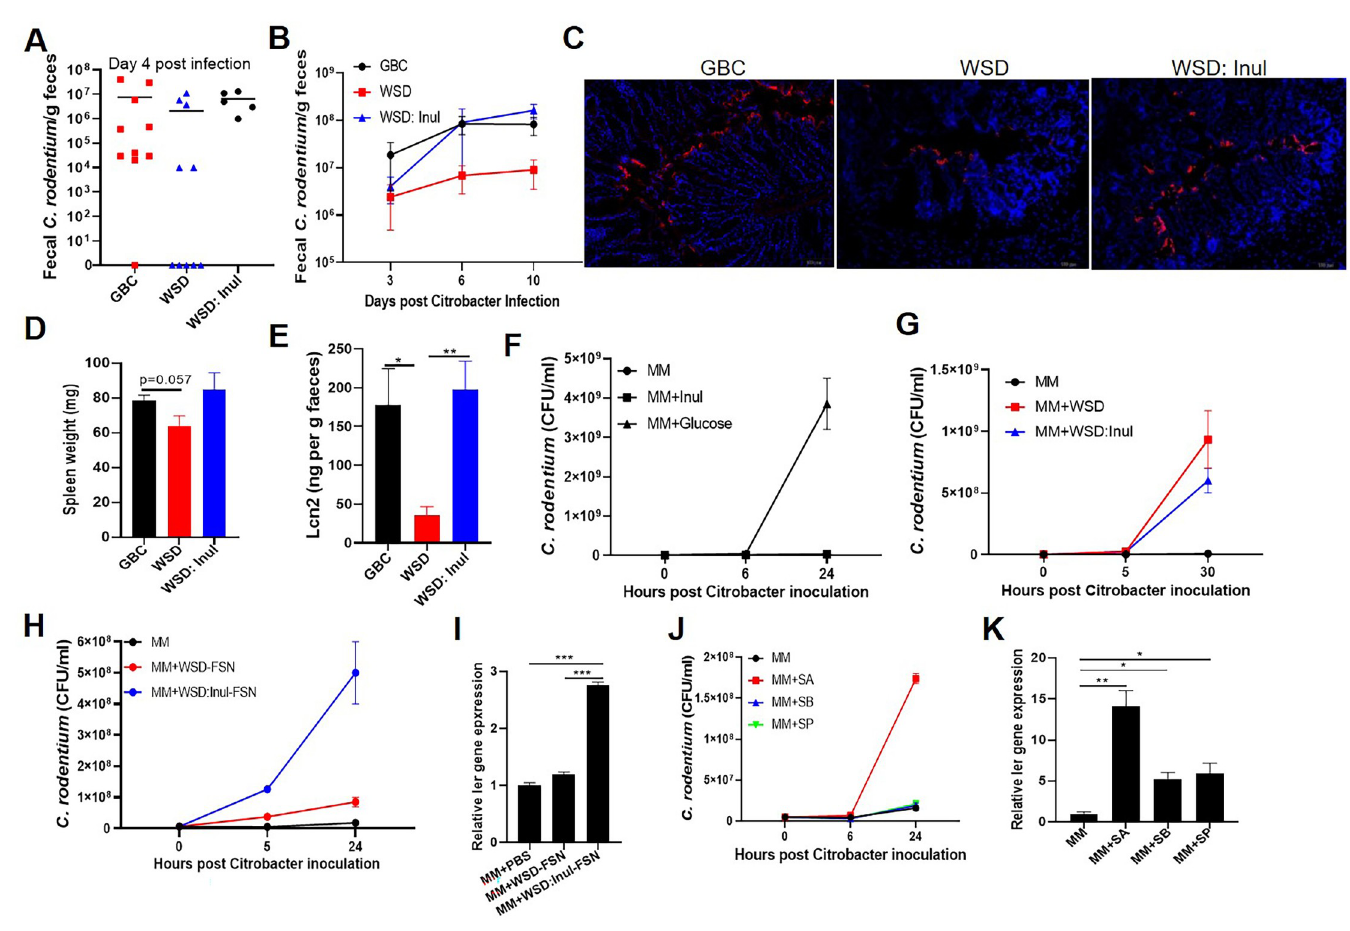
Fig 7. Fermentable dietary fiber promotes initial colonization of C . rodentium . A . Mice fed with indicated diets (n = 5–10) were orally administered 2 × 10 8 CFU C . rodentium per mouse and fecal C . rodentium CFU measured 4 days later. B. Mice were administered with a dose of 4 × 10 8 CFU C . rodentium /mouse , fecal C . rodentium CFU measured at indicated times. C-E . Mice were euthanized on day 10 post-inoculation. Immunofluorescent staining of C . rodentium in colon (C), Spleen weight (D), Fecal Lcn-2 (E). F-k. In vitro growth of C . rodentium in minimal medium supplemented with inulin (Inul) or glucose (Glu) (F), WSD diets +/- inulin (G), fecal supernatant from mice fed WSD +/- inulin (H&I), or short-chain fatty acid including sodium acetate (SA), sodium butyrate (SB) and sodium propionate (SP) (J&K). Expression of ler in minimal media supplemented with fecal supernatant from WSD diets +/- inulin (I) or indicated purified short-chain fatty acid (K) measured by using the reporter ler-lux C . rodentium strain.